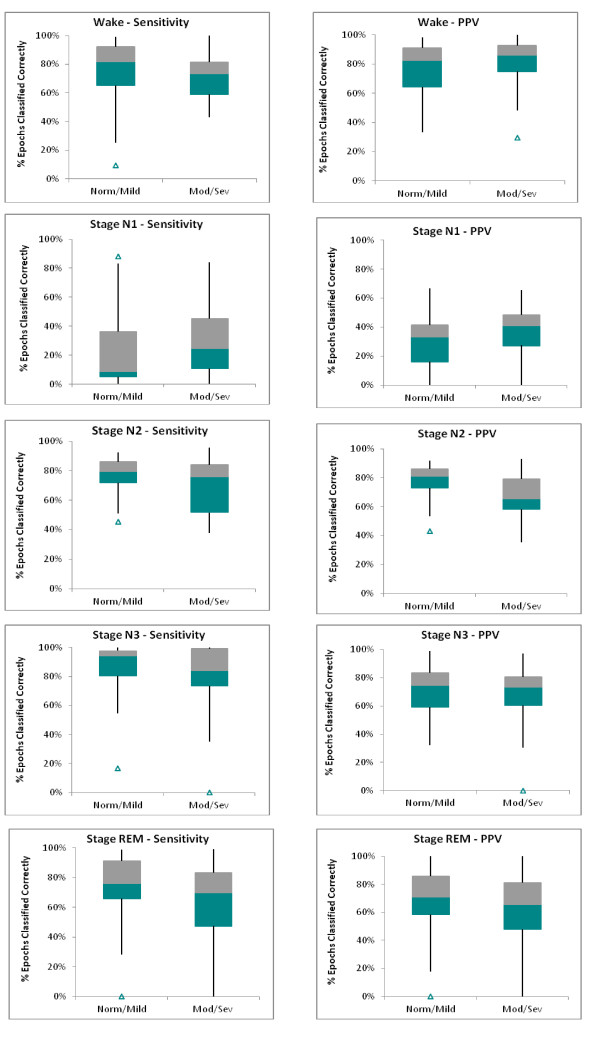
Box-Whisker plots comparing stage-specific sensitivity and positive predictive value (PPV) by SDB severity. The box represents the distributions of the 2nd and 3rd quartile about the median, the whiskers represent the 10% and 90%, and the Δ identifies outliers. Only subjects with a minimum of 20 manually scored epochs of the pertinent stage were included the respective plot.